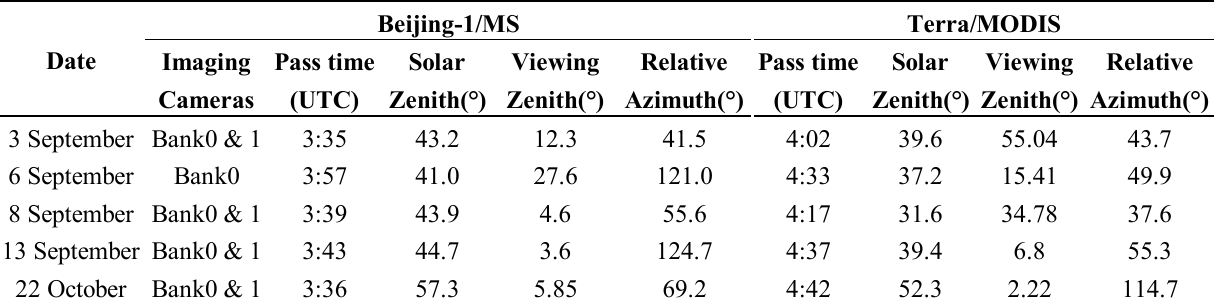
Table 1. Acquisition information of Beijing-1/MS and Terra/ Moderate Resolution Imaging Spectroradiometer (MODIS) images of